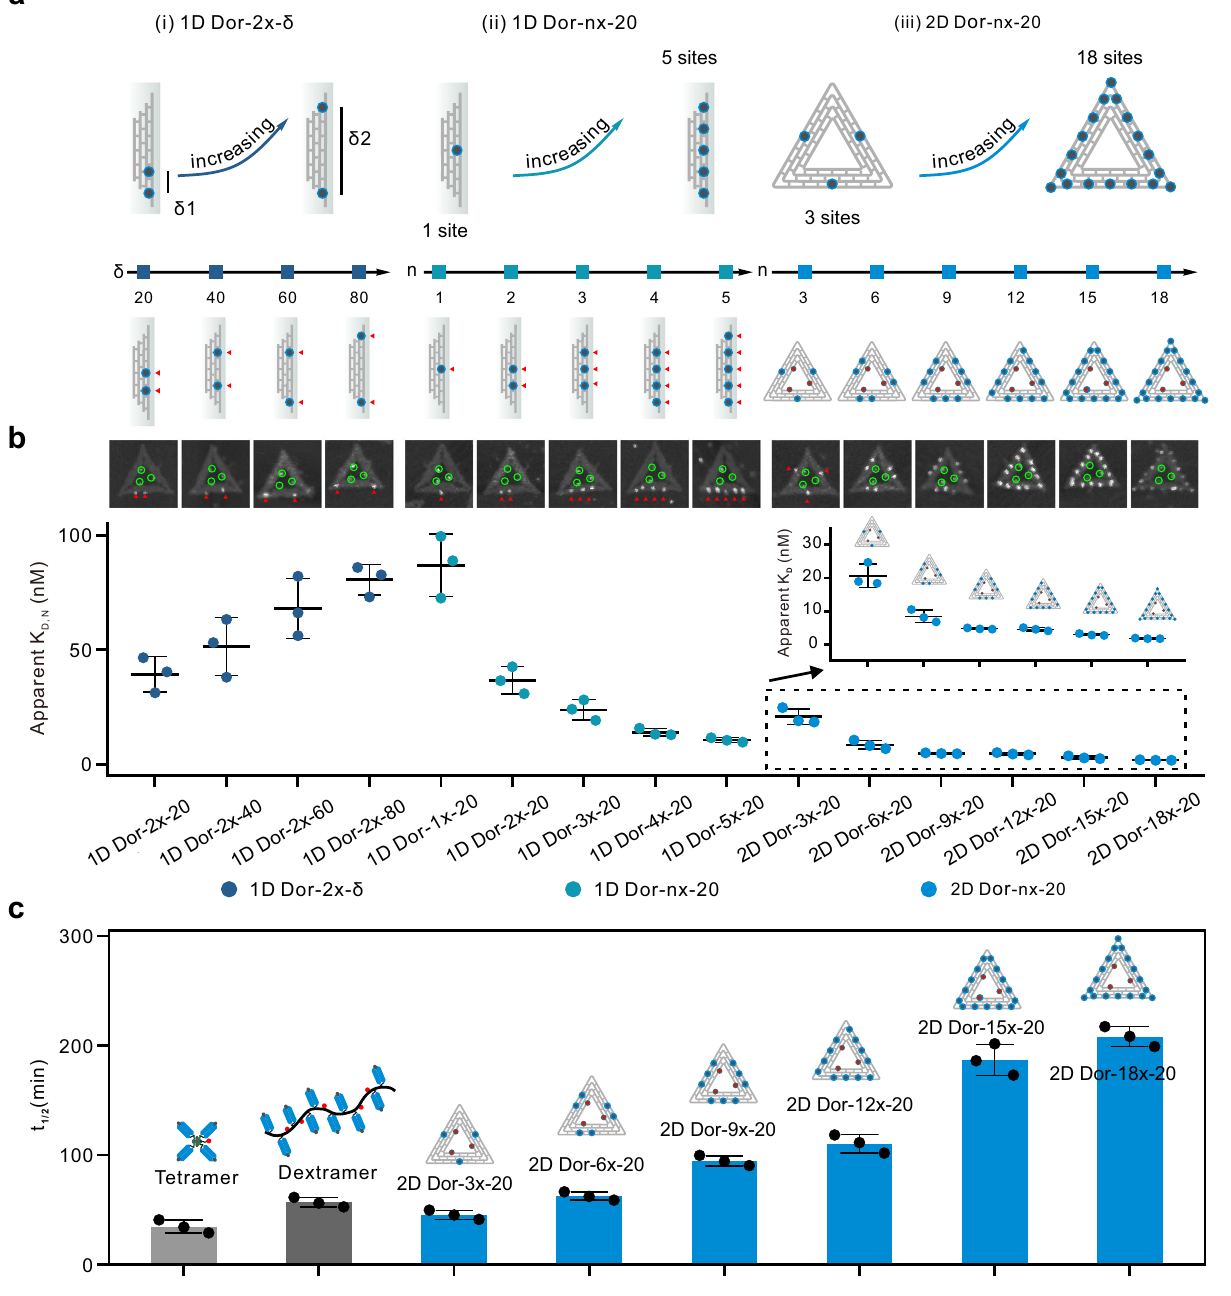
Fig. 2 Effect of inter-pMHC spacing and pMHC valency on binding avidity of Dor-pMHCs binding to TCRs. a Schematic illustrating the design of three series of Dor-pMHCs, including 1D Dor-2 x - δ , 1D Dor- nx -20, 2D Dor- nx -20. n indicates the number of SA-binding site and δ indicates the inter-pMHC spacing on each edge. b The apparent dissociation constant (apparent K D,N ) of different types of Dor-pMHCs binding to OT-1 naive T cells at 4 °C. Inset: AFM images of Dor-pMHCs. N indicates the copy number of pMHC molecules on Dor-pMHCs. c Summary of the half-lives ( t 1/2 ) and dissociation kinetics of pMHC multimers (including tetramer, dextramer, and 2D Dor- nx -20) binding to OT-1 naive T cells at 4 °C measured using fl ow cytometry in the presence of saturated amounts of anti-H-2K b MHC antibody at 4 °C. Data represent the mean ± s.d. from n = 3 ( b , c ) independent experiments. Source data are provided as a Source Data fi